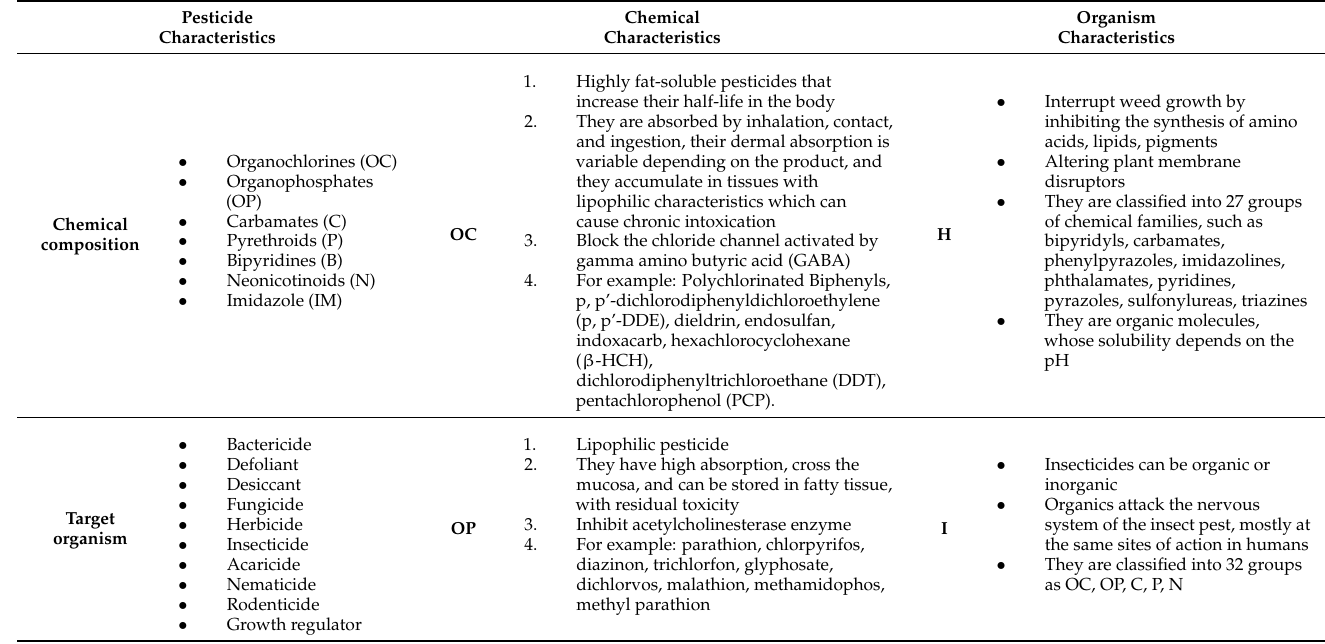
Table 1. Characteristics of pesticides by different